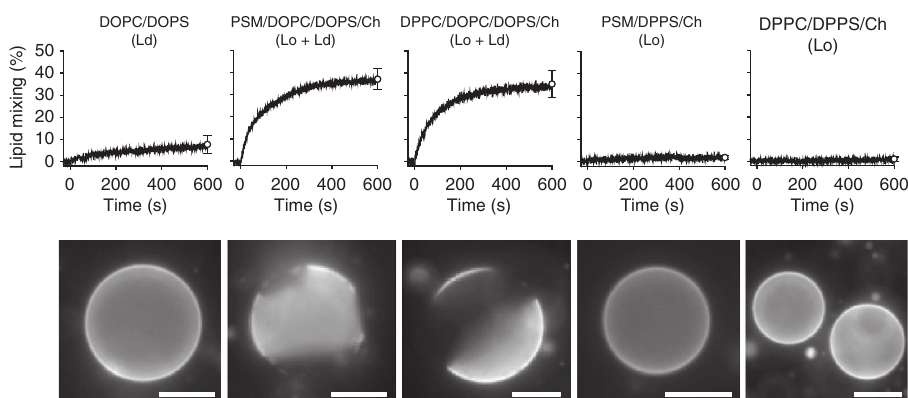
Figure 2 | Comparison of the effect of Lo phase-promoting PSM and DPPC on lipid mixing mediated by HIV-FP. Lipid mixing with 1 m M HIV-FP added to 50 m M LUVs composed of from left to right DOPC/DOPS (3:1), PSM/DOPC/DOPS/Ch (2:1:1:1), DPPC/DOPC/DOPS/Ch (2:1:1:1), PSM/DPPS/Ch (2:1:1) and DPPC/DPPS/Ch (2:1:1; top row). Fluorescence micrographs of GUVs with corresponding lipid compositions and labelled with 0.1mol% Rh-PE (bottom row). Scale bars, 10 m m. Error bars are s.d. of three replicates.